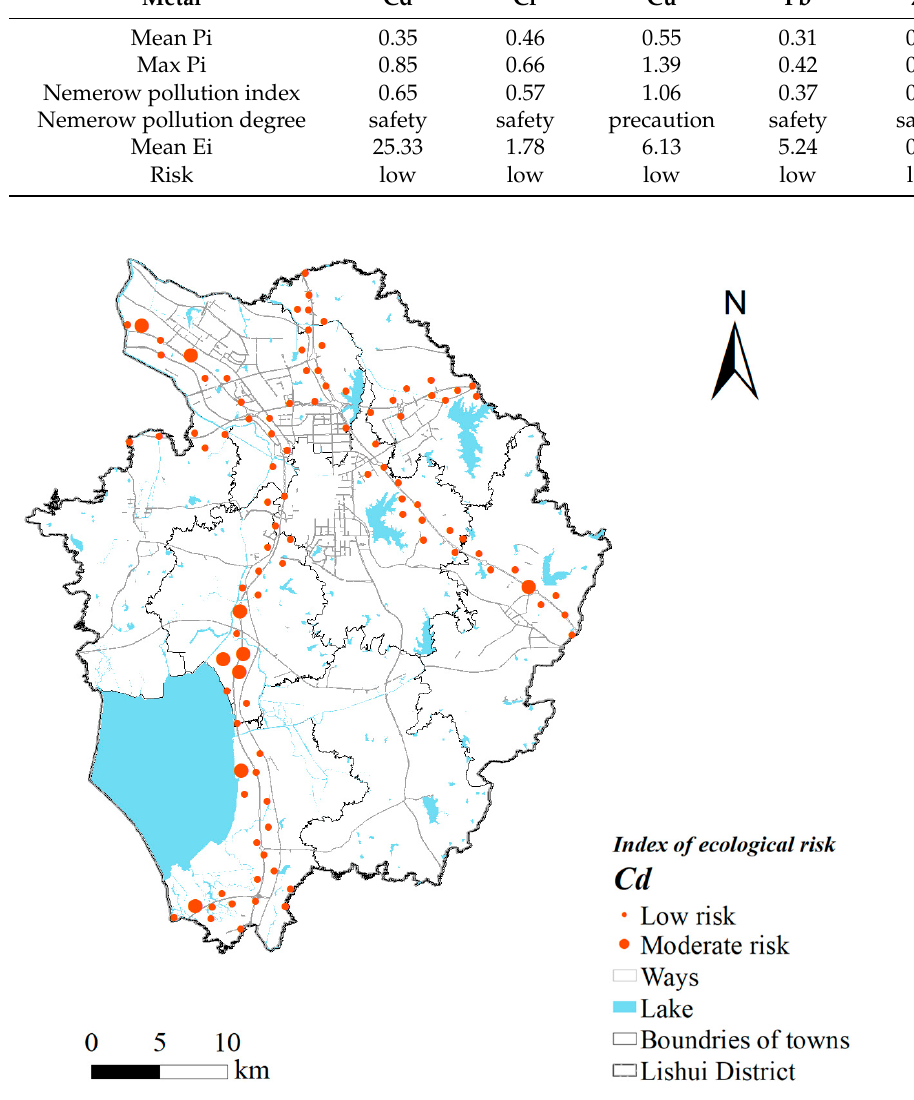
Figure 3. Ecological risk index of Cd.